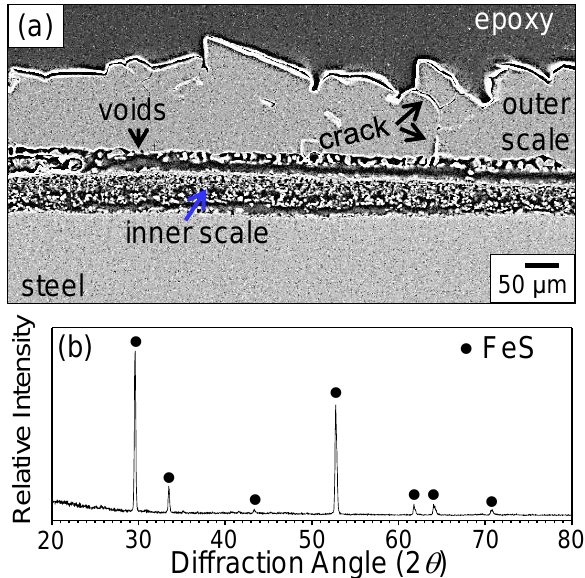
Figure 3. Uncoated steel after corrosion in N 2 /0.1% H 2 S at 600 °C for 50 h: ( a ) SEM cross-sectional image; ( b ) XRD pattern.